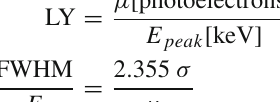
Identification of α particles exploits the Pulse Shape dis- crimination capability of NaI(Tl) crystals, where signals induced by α decays are faster than β/γ ones. In partic- ular, the amplitude-weighted mean time (cid:3) t (cid:4) 600 (defined in Sect. 4.4), gives excellent separation between α particles